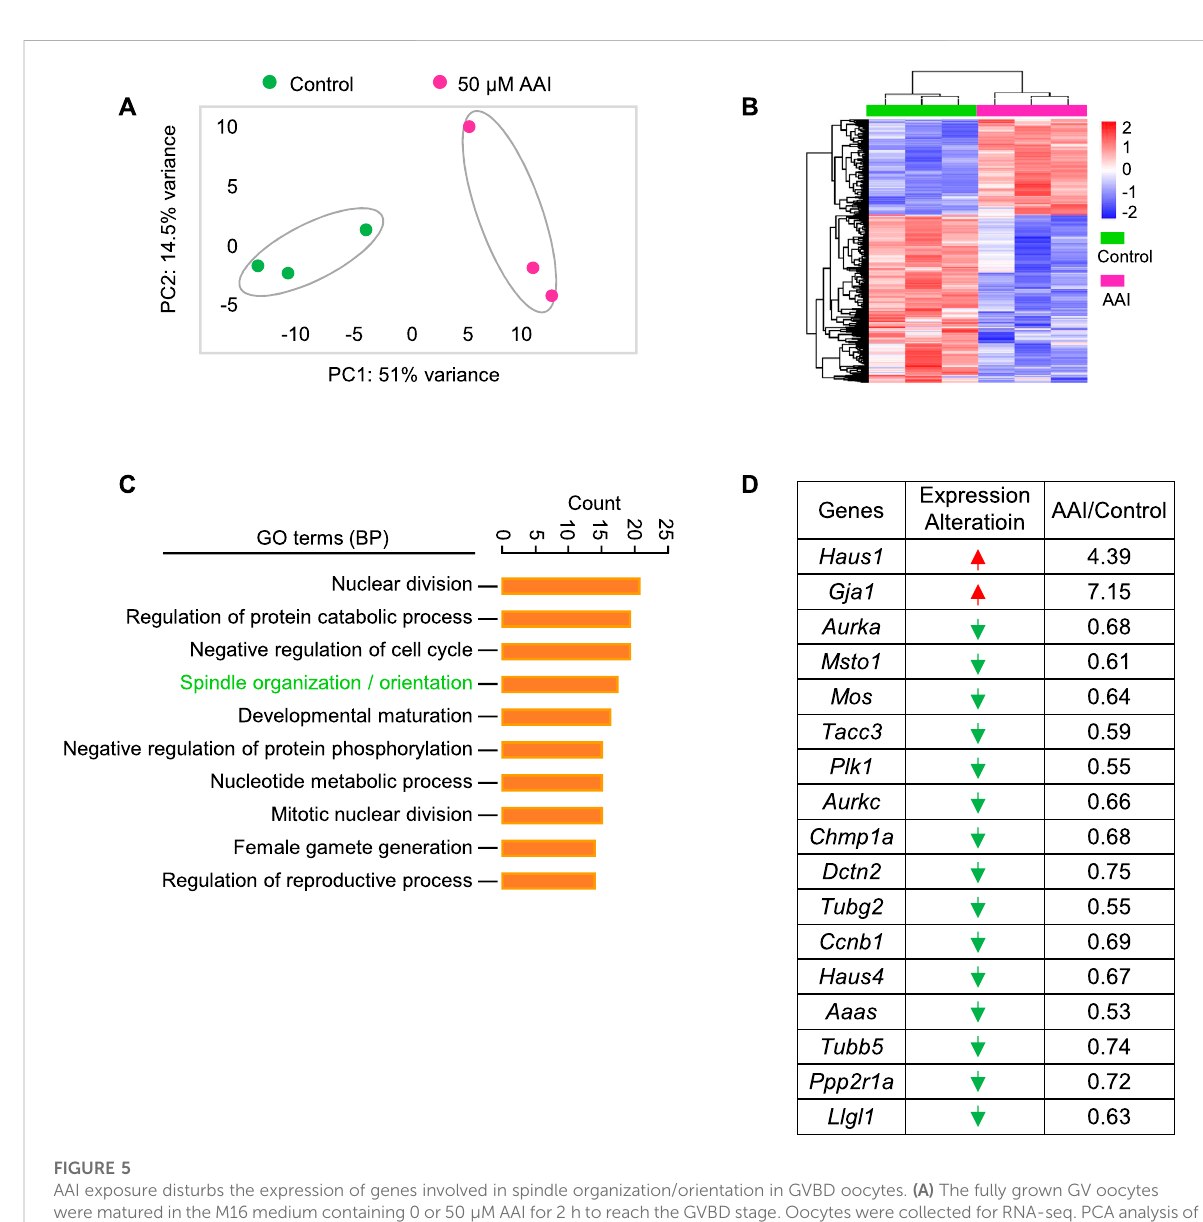
Frontiers in Cell and Developmental